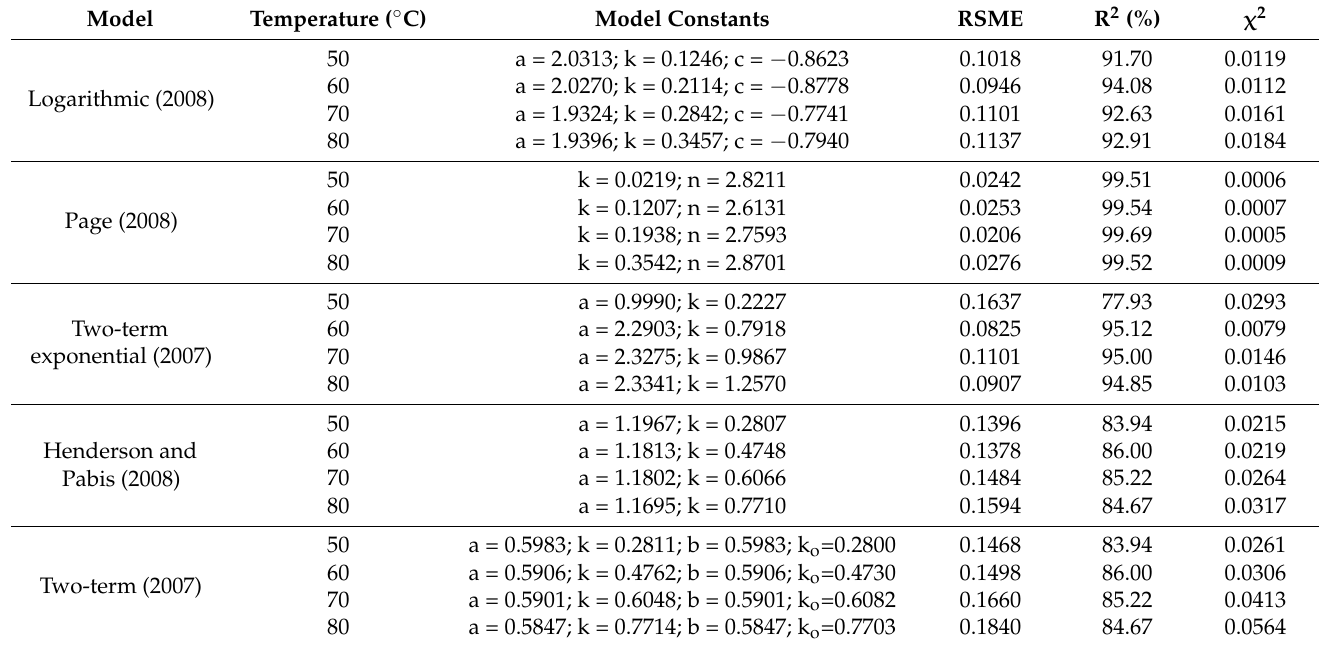
Table 6. Regression parameters of tested mathematical models for foam-mat drying of magenta leaves extract at different temperatures.